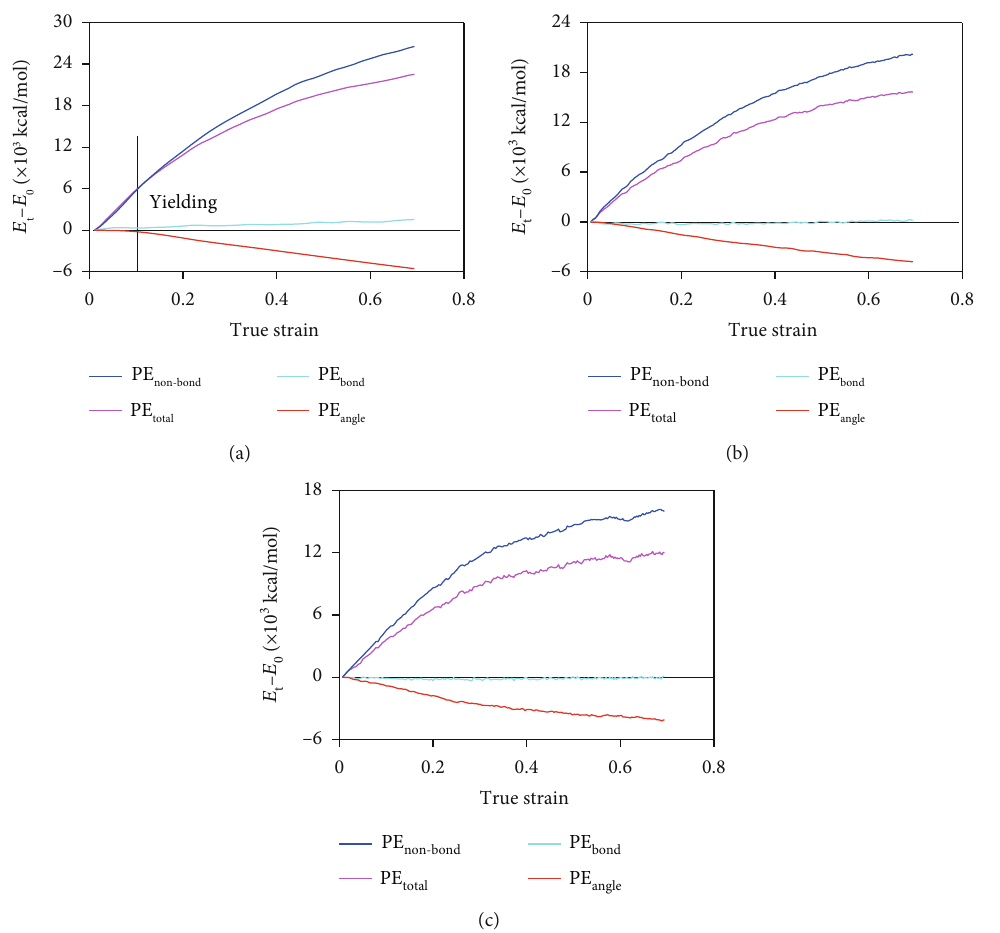
Figure 6: Variations of the potential energy of the coarse-grained PU matrix versus true strain for a strain rate of (a) 2 × 10 11 /s, (b) 5 × 10 10 /s, and (c) 1 × 10 10